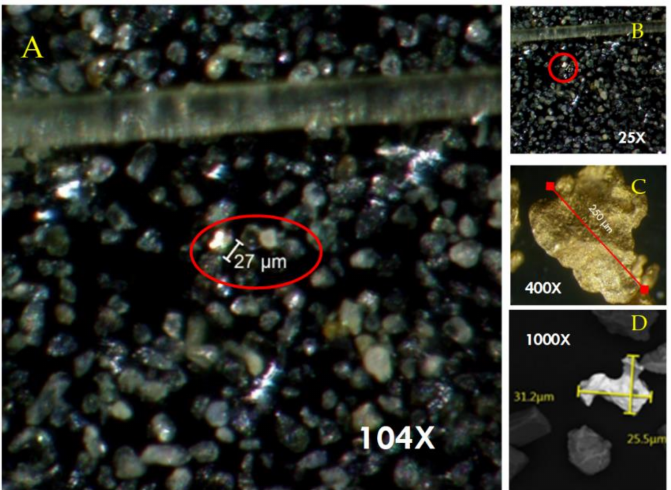
Figure 4. Examples of gold grains, as seen at various magnifications with different types of micro- scope. ( A ) 27 µ m gold grain seen at 104 × with a high-end apochromatic stereomicroscope (Leica M205-c, annular illumination). The blurred horizontal bar is a human hair. Tests indicate that sorting with such a stereomicroscope increases the gold grain counts by about 57%, compared to the usual stereomicroscopes. ( B ) Same field of view with a conventional plan-achromatic stereomicroscope (Leica MS-5, oblique illumination) at 25 × . The 27 µ m gold grain is barely recognizable, although such equipment is in current usage in most laboratories. ( C ) An example of a large 250 µ m grain seen with a metallographic dark-field microscope at 400 × (Wild M21). The limited depth of field does not enable the proper focus of the edges, despite the grain being a flat flake. ( D ) Back-scattered electron image of a complex 31 µ m gold grain, acquired with an automated SEM routine. The depth of field and resolution of minute details, enabling textural studies, should be noted. Such images were acquired for every single grain using the automated routine. The scale bars were added manually.